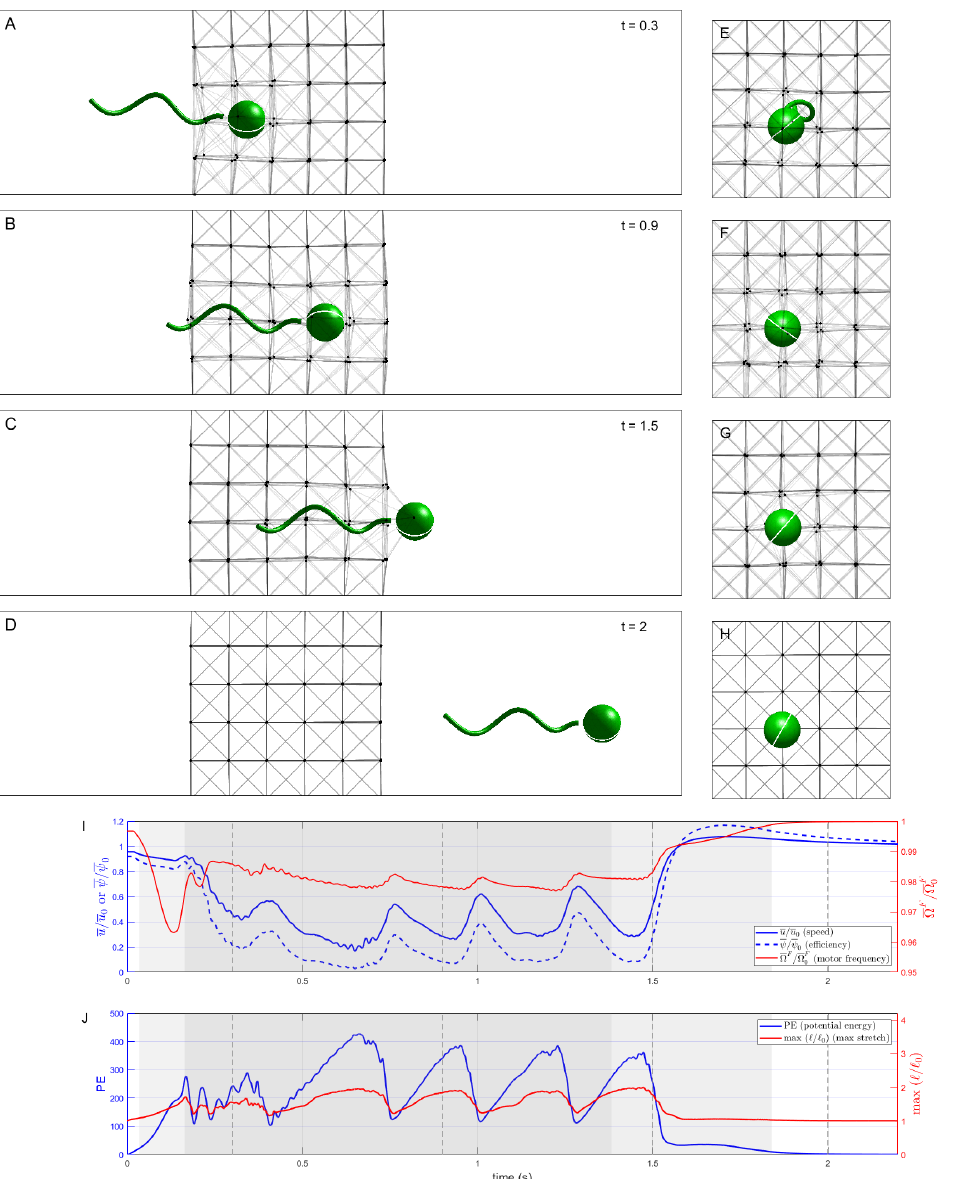
Figure 3. Summary of results for E = 25 mPa, η = ∞ (Hookean elements). Panels ( A – H ): side views and frontal views at four selected times, zoomed in to highlight the dynamics near the microswimmer. A white equitorial band is depicted around the cell body to demonstrate rotation. Panel ( I ): timeseries of swimming speed, motor frequency, and power efficiency, all averaged over a body rotation and normalized to the Newtonian case ( E = 0 mPa). Panel ( J ): timeseries of potential energy of the network (PE) and the maximum relative strain (cid:96) / (cid:96) 0 . Vertical dashed lines correspond to when each snapshot was taken. Leftmost light gray shading corresponds to when any part of the spherical body but none of the flagellum is inside the rectangular volume initially occupied by the network. Dark shading corresponds to when both the body and flagellum are each at least partially inside. Rightmost light shading corresponds to when part of the flagellum but none of the body is inside. Unshaded sections correspond to when the swimmer is completely outside this rectangular volume. See Supplementary Materials Video S1 for an animated